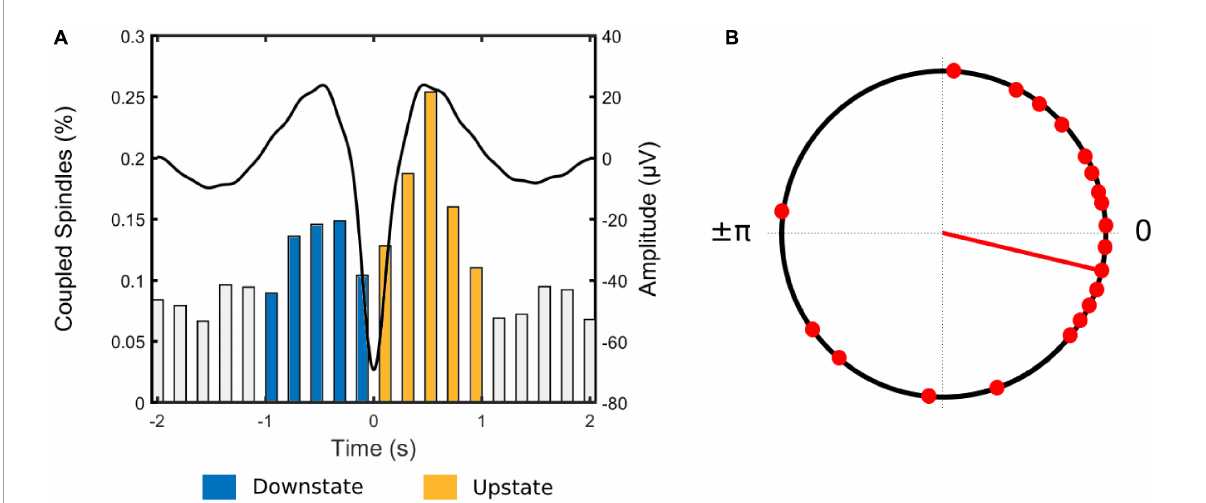
FIGURE2 (A) Coupled spindle percentage histogram for all participants. Each bar represents the number of coupled spindles detected in an interval of 200 ms divided by the total number of spindles averaged across all participants. Average slow wave coupling window for all participants is superimposed In black. (B) Circular plot of preferred phase for each individual (slow wave phase at spindle amplitude maximum). Red dots denote an individual preferred phase (0 ◦ slow wave -upstate peak, ± 180 ◦ slow wave downstate peak). The direction of the line indicates the preferred direction of the grand average. Most individuals exhibit spindles adjacent to or immediately following the positive slow wave peak at 0 ◦ .